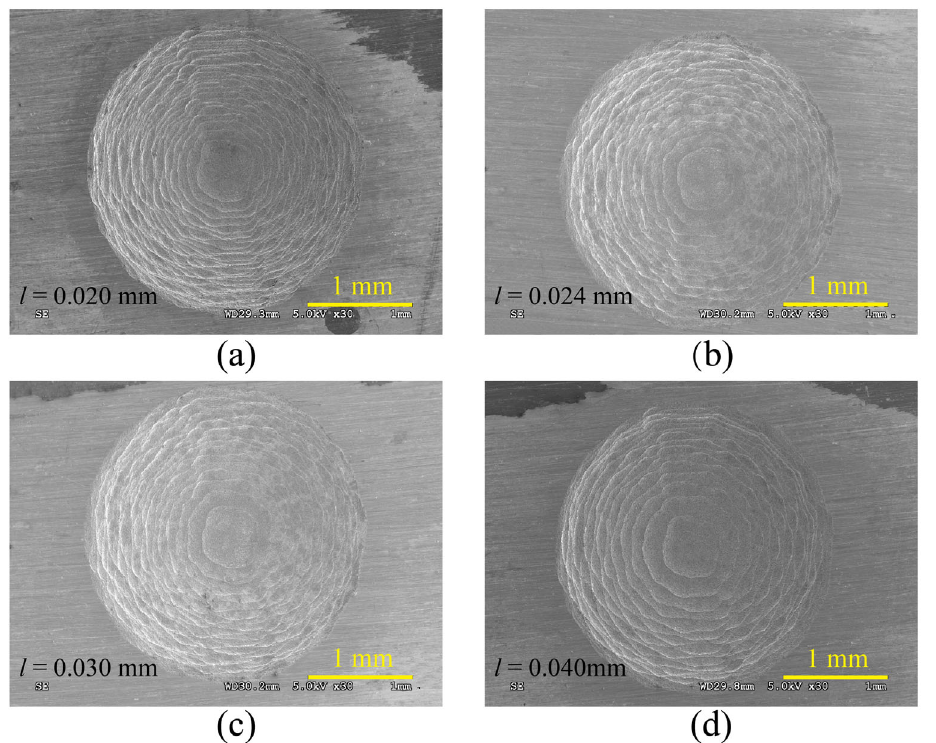
Figure 7. Morphology of ball sockets under different initial layer thicknesses. ( a ) l = 0.020 mm; ( b ) l = 0.024 mm; ( c ) l = 0.030 mm; ( d ) l = 0.040 mm.